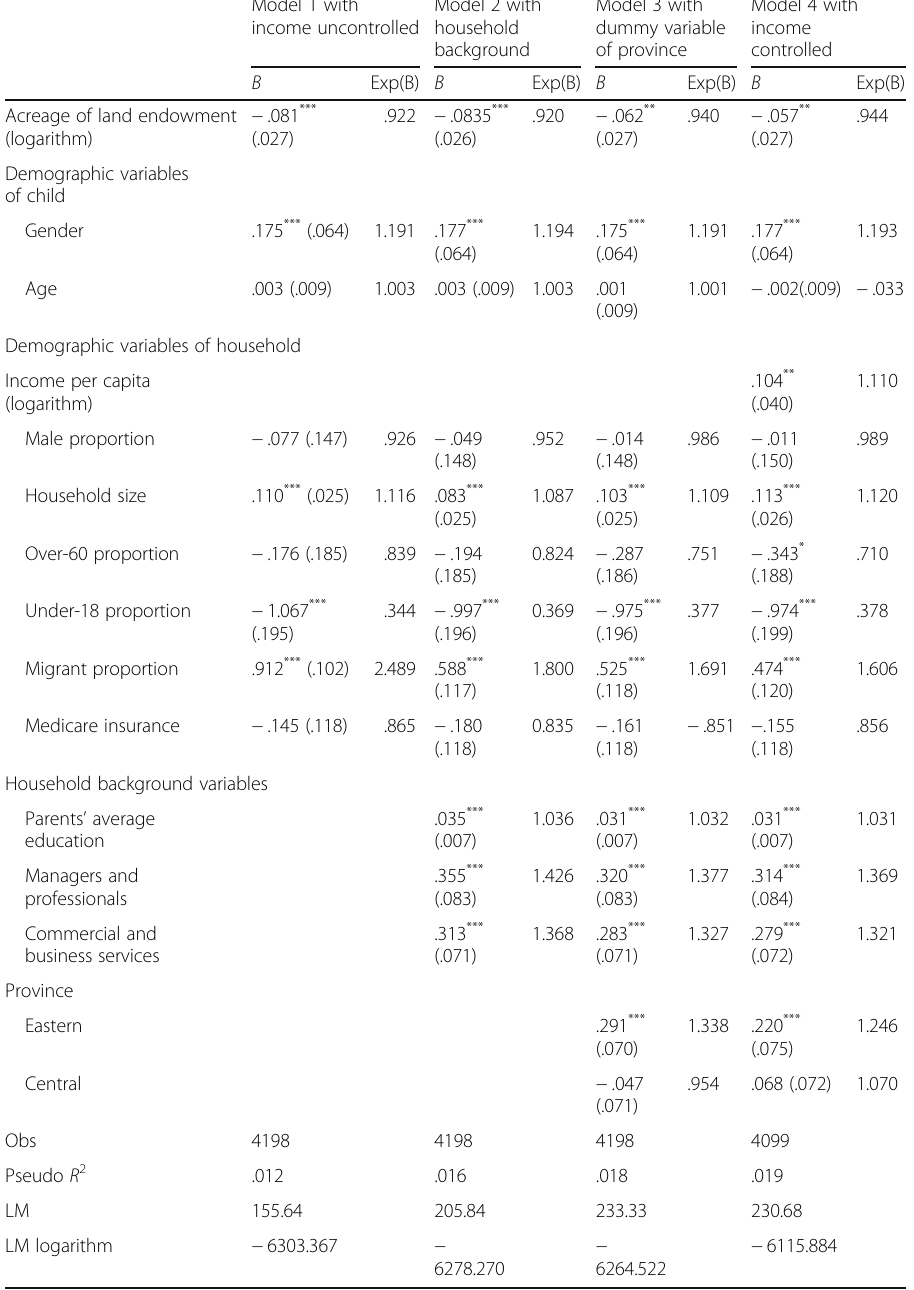
Table 2 Land and education level of rural